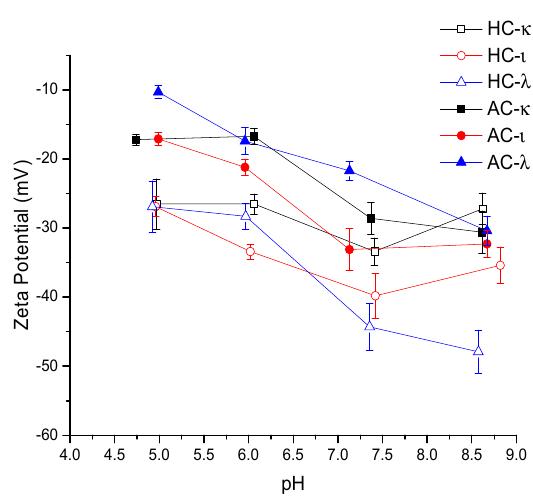
Figure 5. Zeta potential titration for hydrochars and activated carbons.